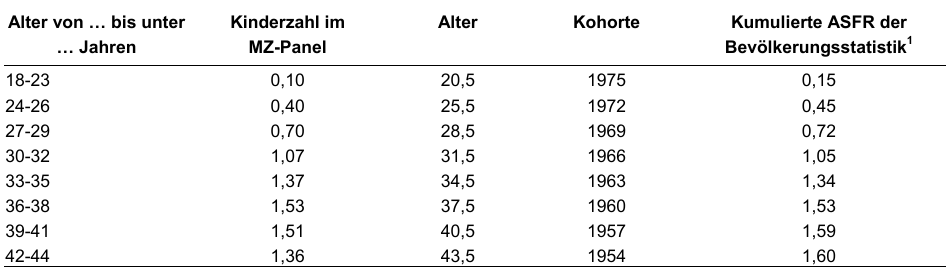
Tab. A1: Vergleich der kumulierten kohortenspezifischen Fertilitätsziffern (CSFR) aus der Bevölkerungsstatistik und der auf Basis des Mikrozensus-Panels 1996 – 1999 rekonstruierten durchschnittlichen Kinderzahl je Frau – Ergebnisse